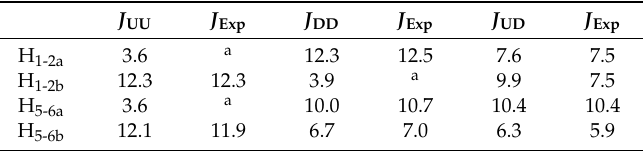
Table 1. Comparison between the theoretical coupling constant for conformer UU (J UU ), DD (J DD ) and UD (J UD ) and the corresponding experimental values (J exp ) measured for compound 13